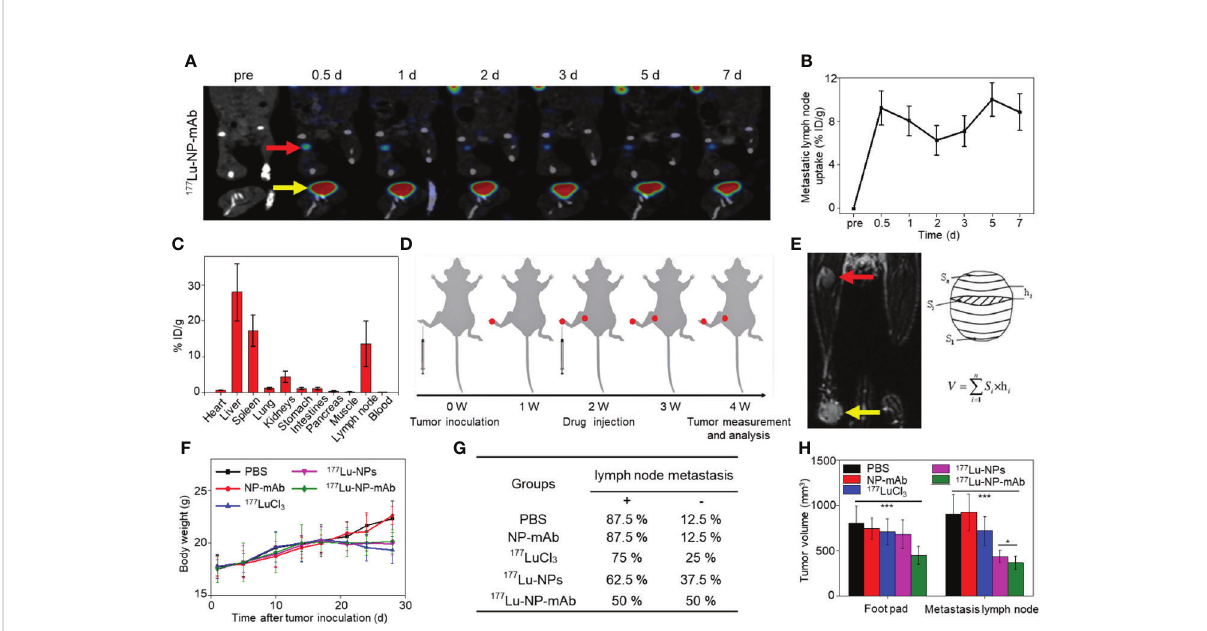
FIGURE 4 In vivo therapeutic ef fi cacy by radiotherapy. (A) SPECT imaging of SKBR3 tumor bearing mice with 177 Lu-NP-mAb injected in the left foot pad at different time points (the red arrow indicates the site of metastatic lymph node, the yellow arrow indicates the injection site in foot pad). (B) Uptake curves of 177 Lu-NP-mAb in lymphatic metastasis at different time points. (C) In vivo biodistribution of 177 Lu-NP-mAb in major organs and tissues at 24 h after injected in the foot pad (error lines represent mean ± standard deviation, n = 3). (D) Schematic diagram of radioisotope therapy to suppress primary tumor and metastasis lymph nodes growth. (E) MRI imaging of lymphatic metastasis model mouse and Schematic diagram of tumor volume calculation method. (F) Changes in body weight of mice in each group during the therapeutic cycle. (G) Lymph node metastasis rate of different groups of mice (PBS, NP-mAb, 177 LuCl 3 , 177 Lu-NPs, and 177 Lu-NP-mAb, n = 8 for each group) after 2 weeks of radioisotope therapy ( + indicates positive lymph node metastasis in mice, - indicates negative lymph node metastasis in mice). (H) The volume of primary tumor and metastatic lymph nodes in different groups of mice after 2 weeks of radioisotope therapy. Asterisks indicate statistical signi fi cance (***P< 0.001, *P<